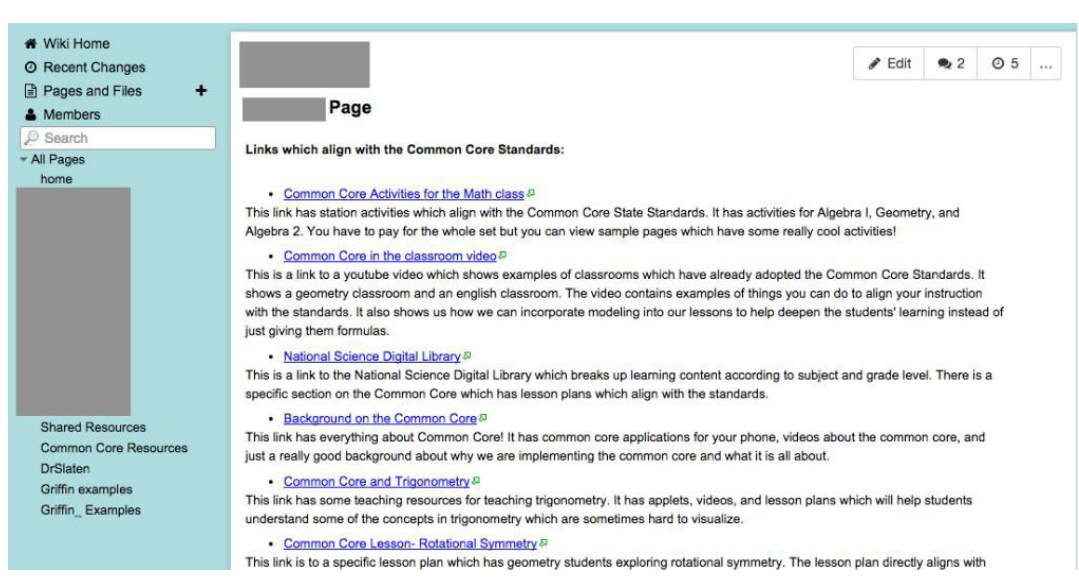
Figure 1. Wiki page science example (p. 4)